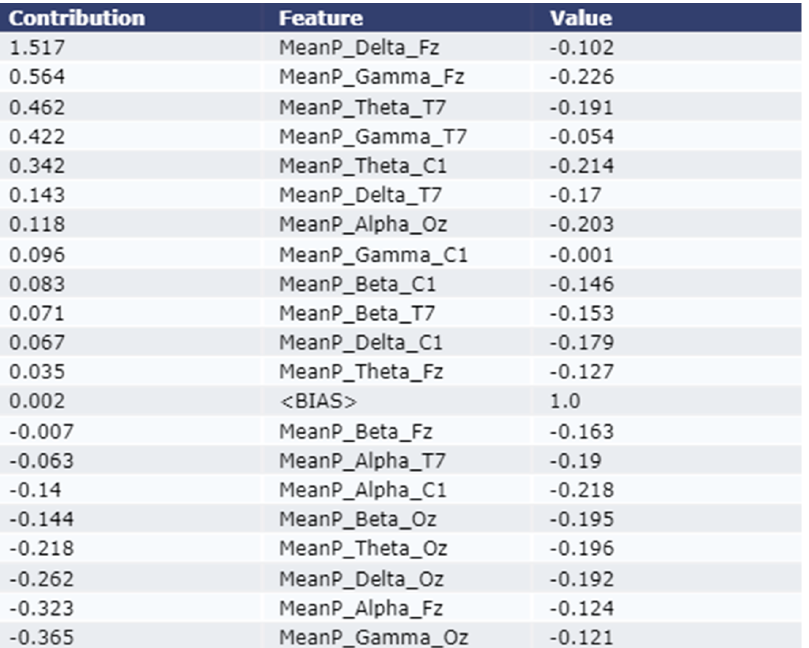
Figure 6. Visualization of the local contribution of EEG features through the LIME model in classi- fying a single test instance (predicted class = Stroke) using the Adaptive Gradient Boosting model. The orange-marked cells represent the features that contributed most to classifying the Stroke class.